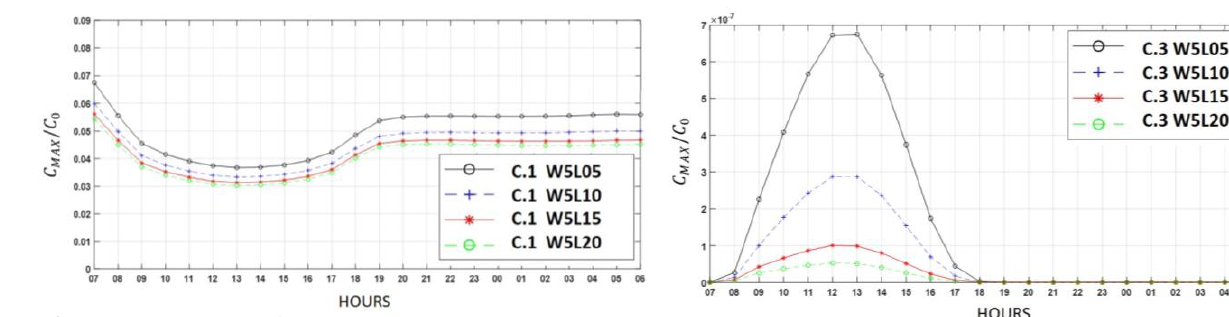
Fig. 4. Daily variation of the nondimensional maximum CO concentration C MAX /C 0 inside the courtyard 1, for the different simulated courtyard dimensions.